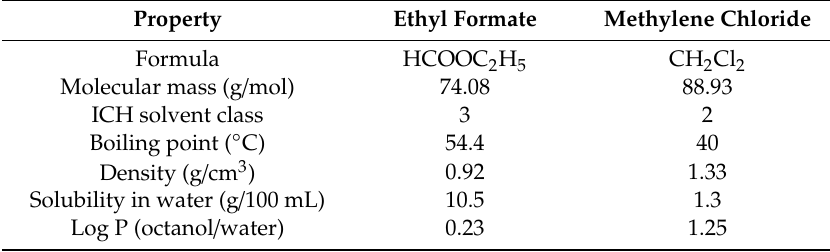
Table 1. Physicochemical properties of ethyl formate and methylene